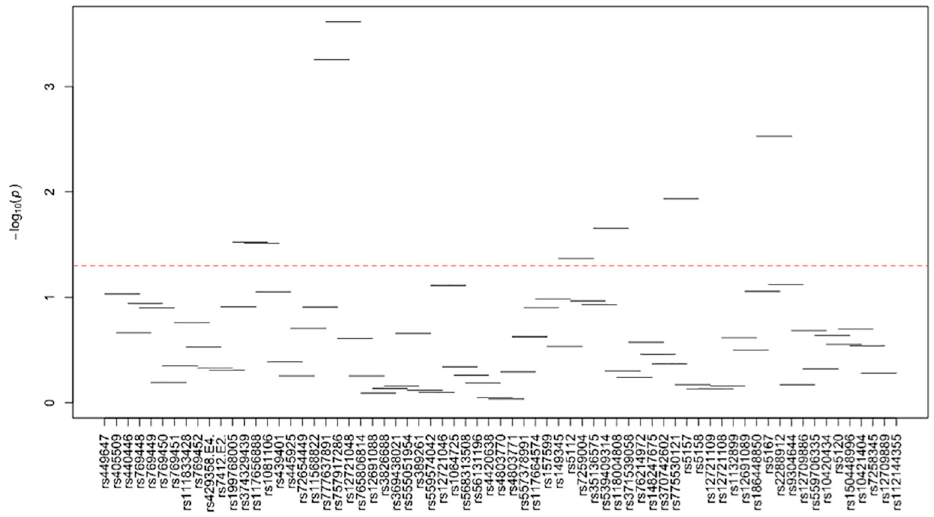
Fig 4. Plots of haplotype-based association analysis results for HDL-C in NHWs. Horizontal lines represent the 4-SNP windows. X-axis direction shows the SNPs genotyped in the regions based on the order of APOE , APOC1 , HCR1 , HCR2 , APOC4 and APOC2 while the Y-axis shows the–log (global p-value) with red line representing the p- value threshold (P =